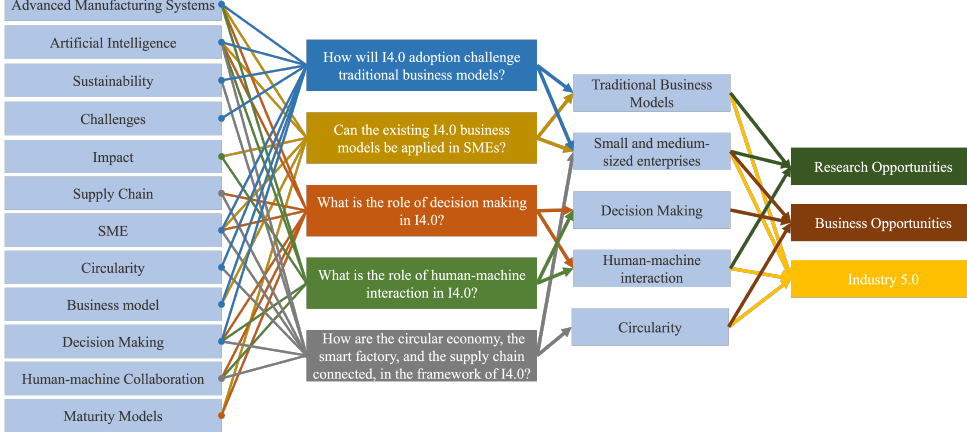
Figure 6. In this figure, the relation among identified research fields, research questions, and discussion points, in addition to the findings are visually